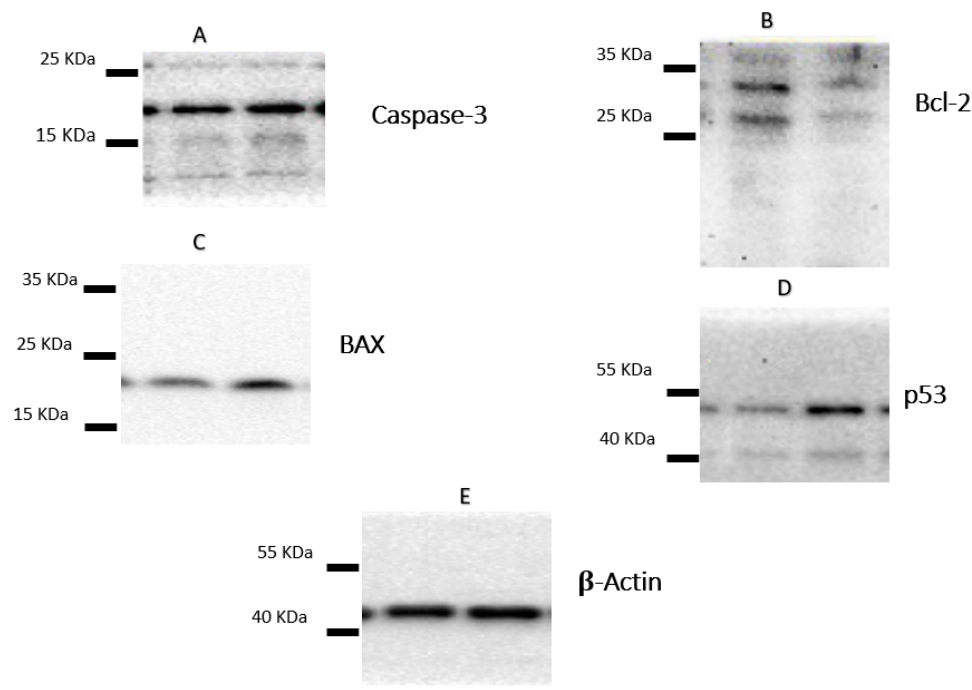
Figure 4. The figure showed the protein expression of ( A ) caspase-3, ( B ) Bcl-2, ( C ) Bax, and ( D ) p53, relative to ( E ) β -actin-mediated apoptosis in lung cancer cell lines (A-549) following treatments with P. tomentosa L . latex (IC 50 = 3.8 µ g/mL).